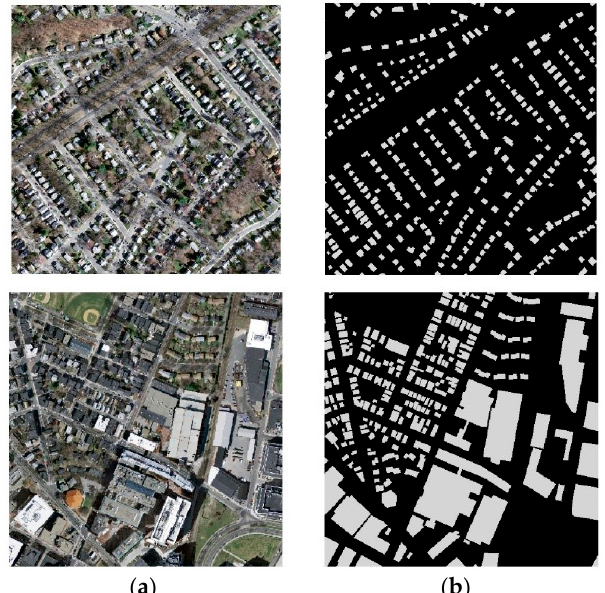
Figure 3. Two sample aerial images from the Massachusetts building dataset; each row contains an original image on the left, which acts as a ground truth of the corresponding image on the right: ( a ) aerial image, ( b ) building mask.